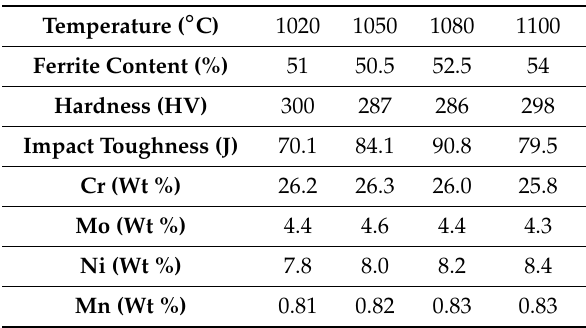
Table 13. Mechanical properties, ferrite and phase stabilizers’ composition of duplex stainless steel at di ff erent temperatures [90].